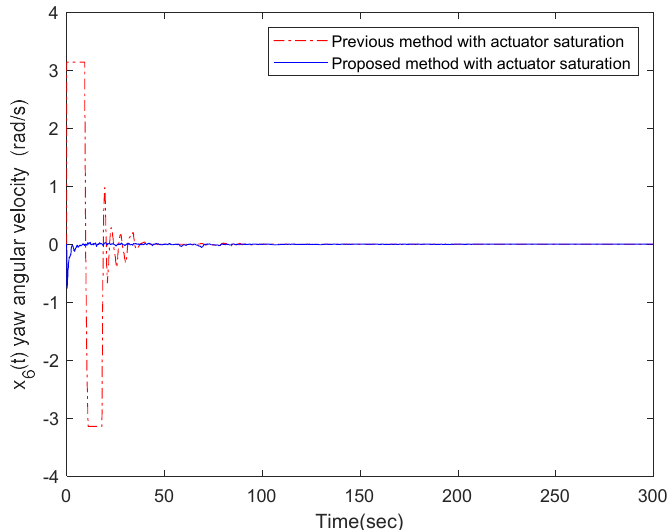
Figure 9. The responses of x 6 ( t ) compared with [29].